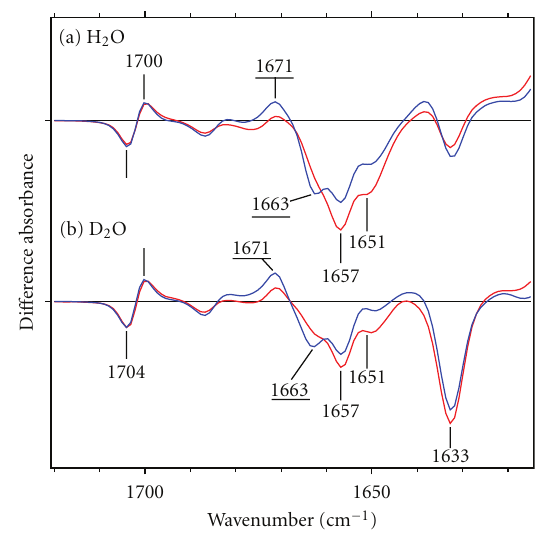
Figure 3: p pR minus p pR infrared di ff erence spectra in the K absence (red line) and presence (blue line) of the transducer pro- tein, p HtrII, in the 1720–1615 cm − 1 region. Spectra are measured at 77 K and pH 7 upon hydration with H 2 O (a) and D 2 O (b). The original data appeared in